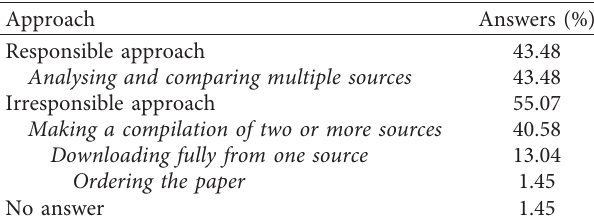
Table 3: Approaches to working on a report